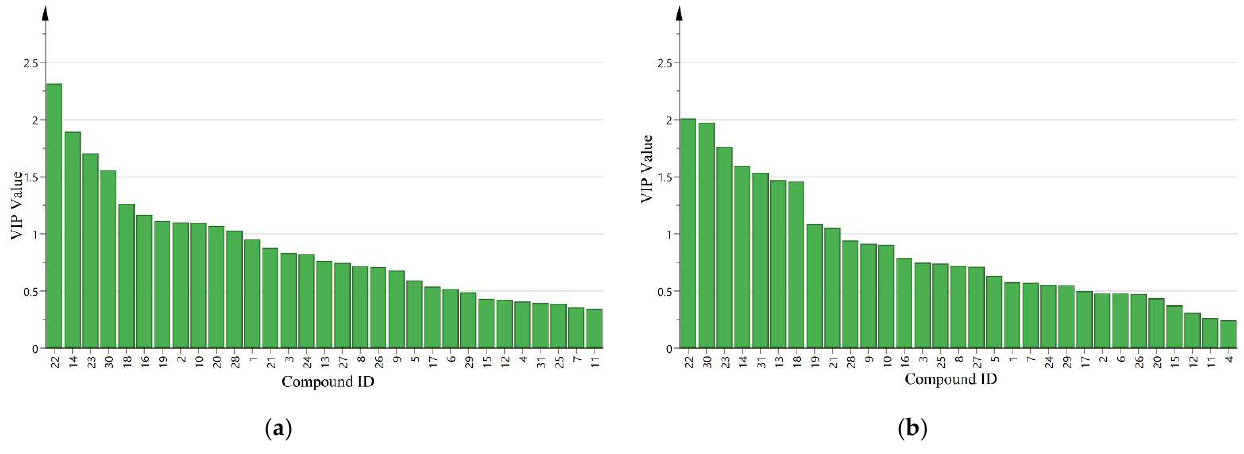
Figure 4. VIP value of cotton plants volatile compounds. ( a ) HIPVs collected at the period from 17:00 p.m. to 21:00 p.m.; ( b ) HIPVs collected at the period from 10:00 a.m. to 14:00 p.m. Compounds ID: 1. ethylbenzene; 2. 1,3-xylene; 3. nonane; 4. α -pinene; 5. Benzaldehyde; 6. ( E )-2-hexenal; 7. β -myrcene; 8. 6-methyl-5-hepten-2-one; 9. decane; 10. octanal; 11. ter- pinene; 12. limonene; 13. ( Z )-3-hexen-1-yl acetate; 14. ( E )- β -ocimene; 15. acetophenone; 16. linalool oxide; 17. linalool; 18. nonanal; 19. DMNT,(3 E )-4,8-dimethyl-1,3,7-nonatriene; 20. hexenyl butyrate; 21. (4 Z )-4-hexenyl butylate; 22. dodecane; 23. decanal; 24. (2 E )-2-hexen-1-yl propanoate; 25. tridecane; 26. unknown; 27. ( E )- β -caryophyllene; 28. ( E )- α -caryophyllene;